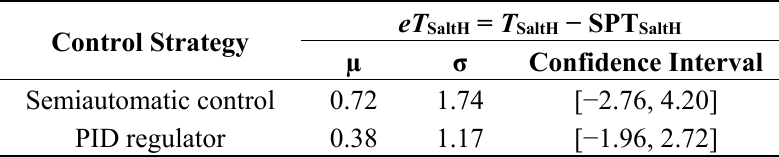
Table 11. Numerical results of the simulation